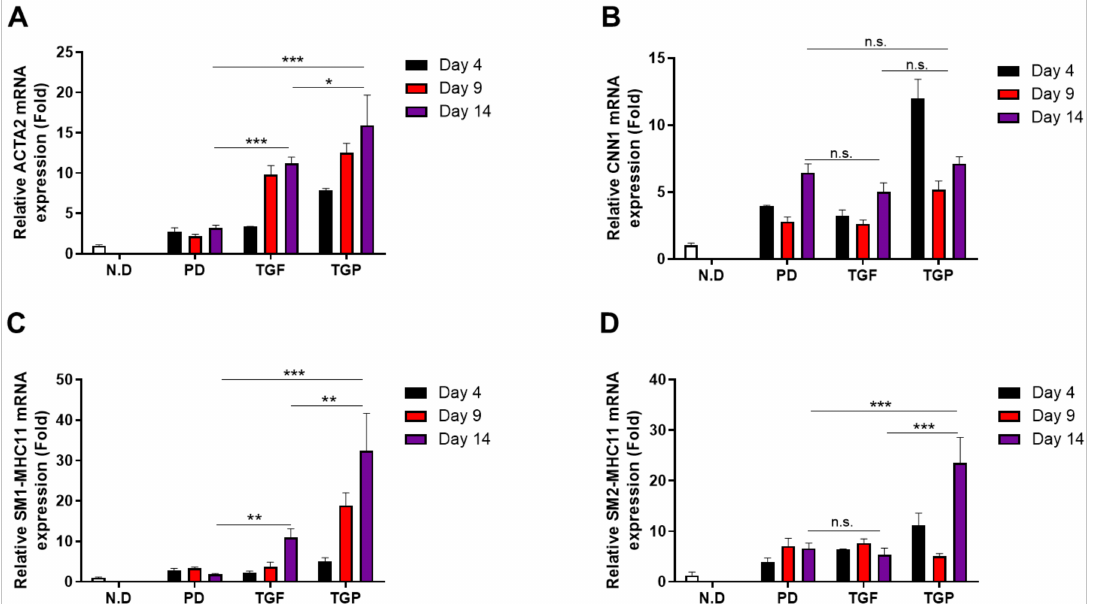
Figure 3. The expression of SMC-specific maker mRNA in SMCs differentiated from hUDSCs at day 4, 9, and 14 of differentiation. The mRNA expression of ( A ) ACTA2 (alpha-smooth muscle actin), ( B ) CNN1 (calponin), ( C ) SM1-MHC11 (smooth muscle 1 myosin heavy chain), and ( D ) SM2-MHC11 (smooth muscle 2 myosin heavy chain) was analyzed by qRT-PCR. The expression of cyclophilin B was used as an internal control: PD; PD98059, TGF; TGF- β 1, TGP; PD98059, and TGF- β 1. Data are presented as mean ± SEM from three independent experiments. n.s.: no significance, * p < 0.05, ** p < 0.01, *** p <